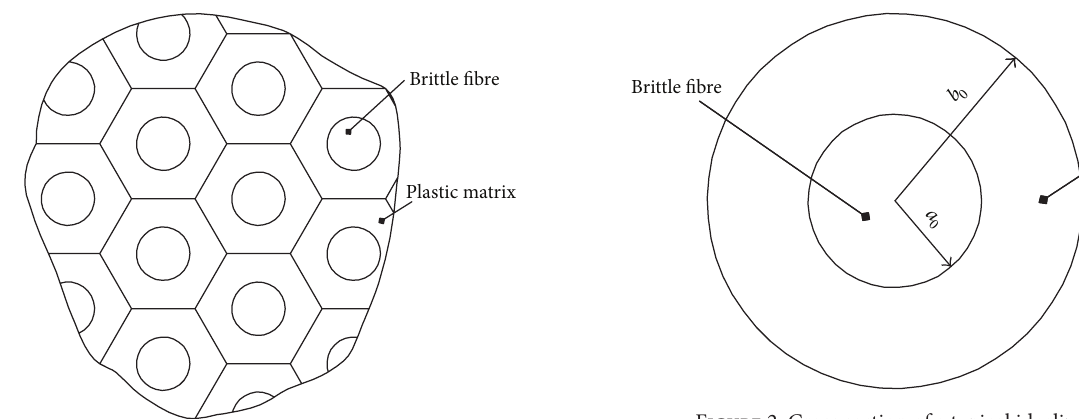
Figure 2: Cross section of a typical idealized